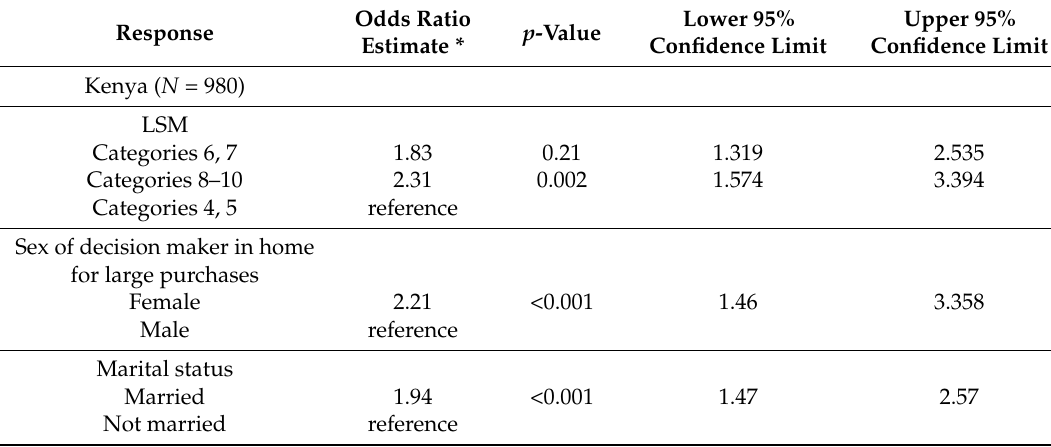
Table 8. Results from Multivariable Logistic Regression. OUTCOME 3: Ownership of two or more stove